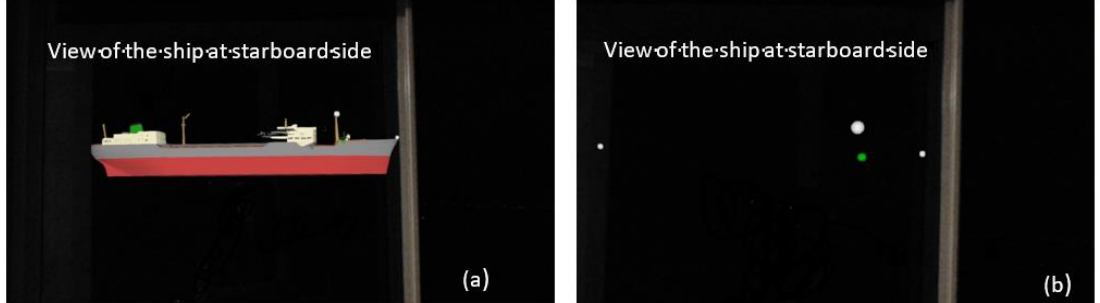
Figure 8. ( a ) The projected holographic ship through the physical window and ( b ) the navigation light projection of the same ship through the ship bridge.